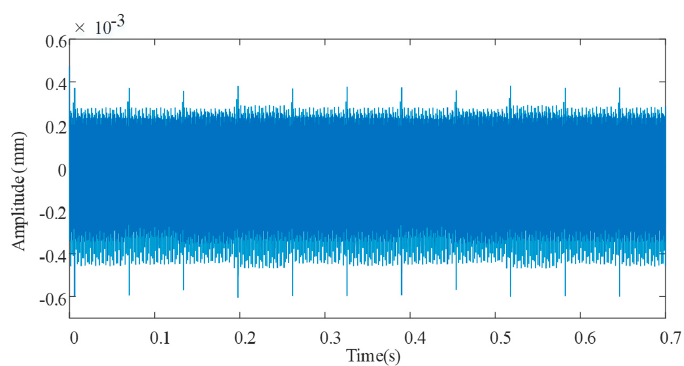
Figure 14. Simulation signal in crack condition.